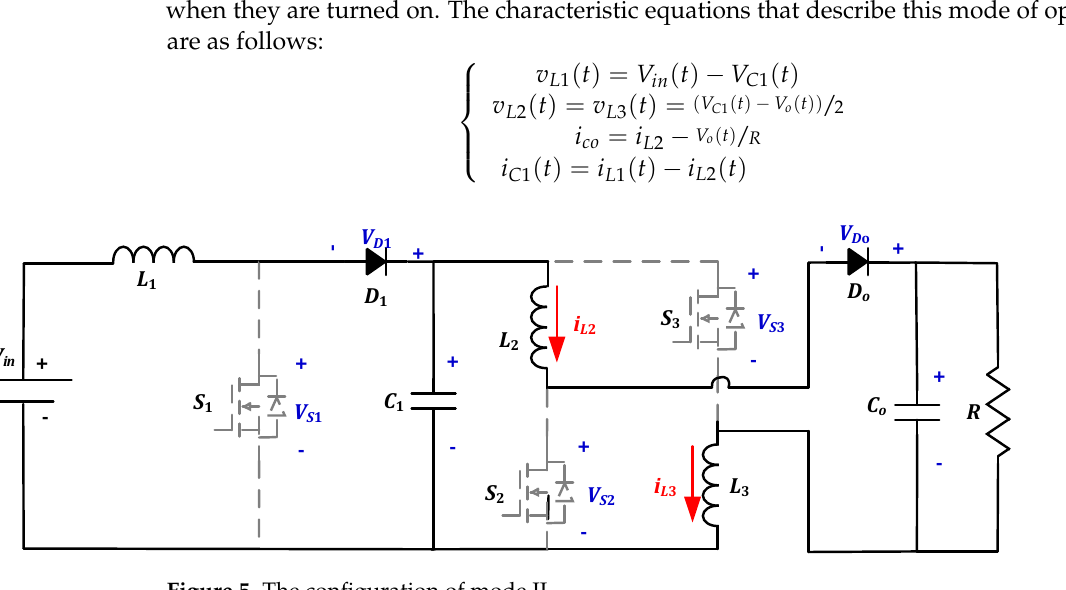
Figure 5. The configuration of mode II.